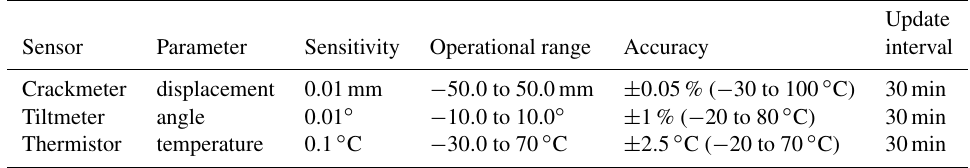
Table 2. Technical specifications of the sensors in CC-MoSys cabled with the acquisition unit – model eDAS 16ch.